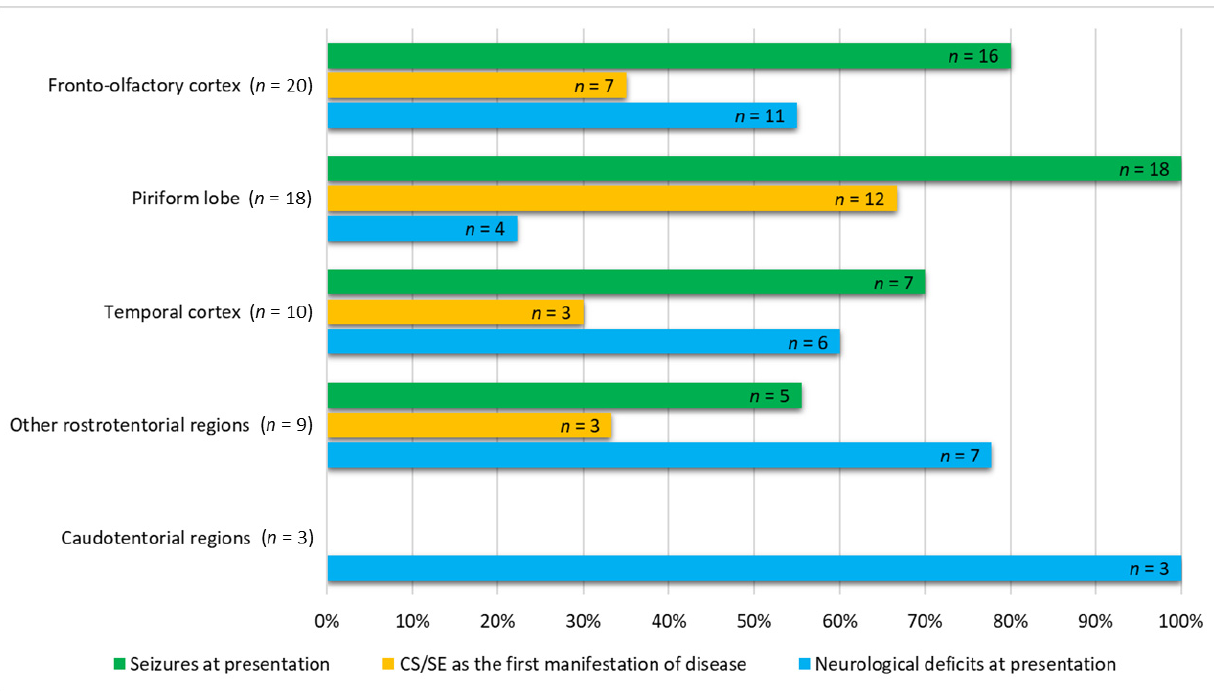
Figure 2. Comparative numbers of cases out of 60 dogs studied having seizures, cluster seizures/ status epilepticus (CS/SE), as the first manifestation of disease, and presence of neurological deficits not considered post-ictal at admission.